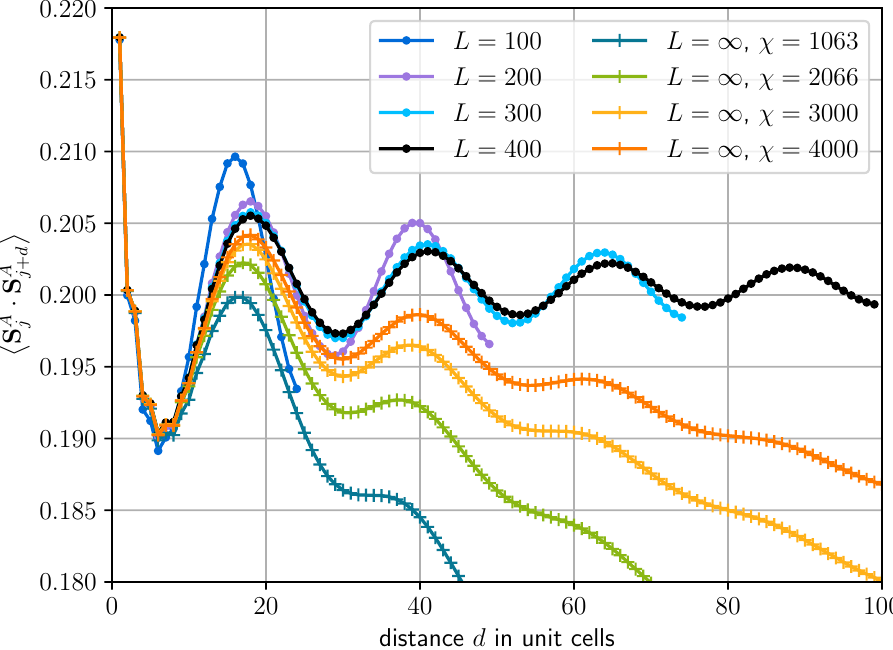
Figure 15: Comparison of the full apex-apex spin correlations for J = − 1, J ′ = 1 between finite rings of different sizes and the infinite system (with the U(1) symmetry exploited) for various bond dimensions as a function of the distance d .